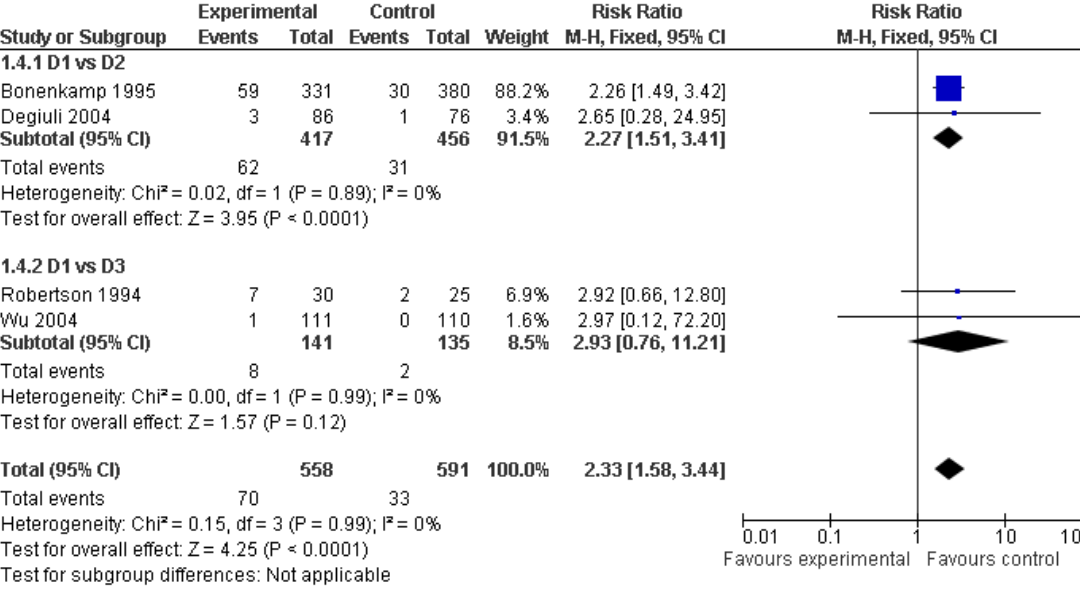
FIGURE 4 – Meta-analysis of reoperation. Effects estimates (odds ratio; 95% CI). Pooled treatment effect is shown as a diamond that spans the 95% CI. No significant statistical heterogeneity between studies results. Overall effect with statistically significant difference between D1 and D2 or D3 lymphadenectomy favoring D1